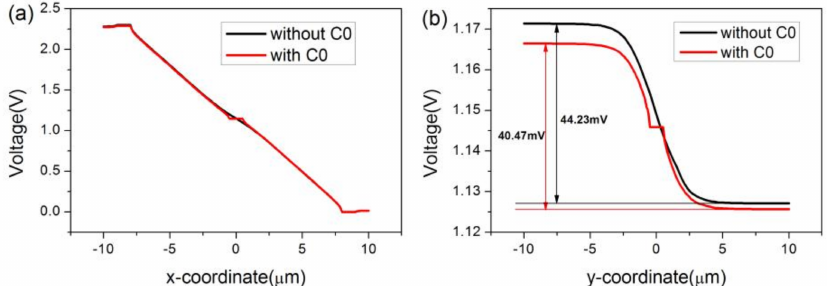
Figure 12. Effects of sensing contact on the distribution of voltage in x and y directions. ( a ) Horizontal Hall device and ( b ) cross-shaped 3D Hall device.